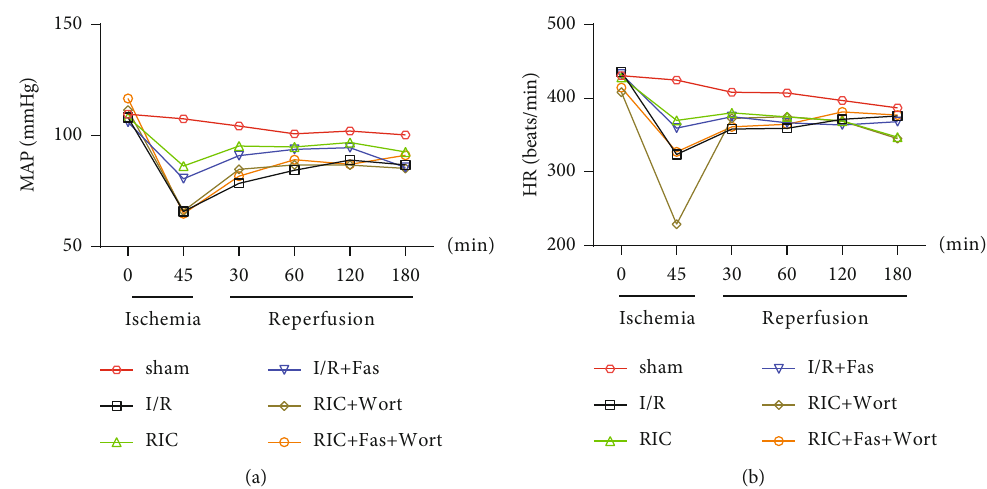
Figure 2: Changes in MAP (a) and HR (b) in the di ff erent groups. HR: heart rate; MAP: mean arterial pressure; sham: LAD with no other intervention; I/R: ischemia/reperfusion; RIC: remote ischemic conditioning; Fas: fasudil; Wort: wortmannin. Data are presented as the mean ± SD ( n = 10